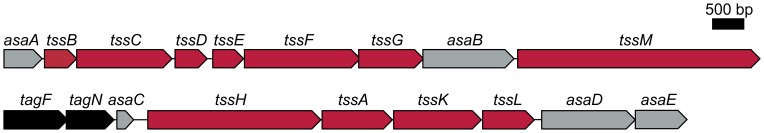
The predicted T6SS gene cluster of A. baumannii strain M2.A single ∼23 kb gene cluster, asaA-tssBC-hcp-tssEFG-asaB-tssM-tagFN-asaC-tssHAKL-asaDE carries 18 putative genes predicted to encode for components of a T6SS. The genome of A. baumannii strain M2 carries genes that are predicted to encode 12 of the 13 core T6SS proteins (tss, colored scarlet), 2 proteins with homology to T6SS-associated proteins in other bacteria (tag, colored black) and 5 proteins encoded by genes only identified in A. baumannii T6SS gene clusters (asa, Acinetobacter type six secretion system-associated, colored gray). Three additional genes whose products have homology to VgrG were identified in other regions of the genome (data not shown).